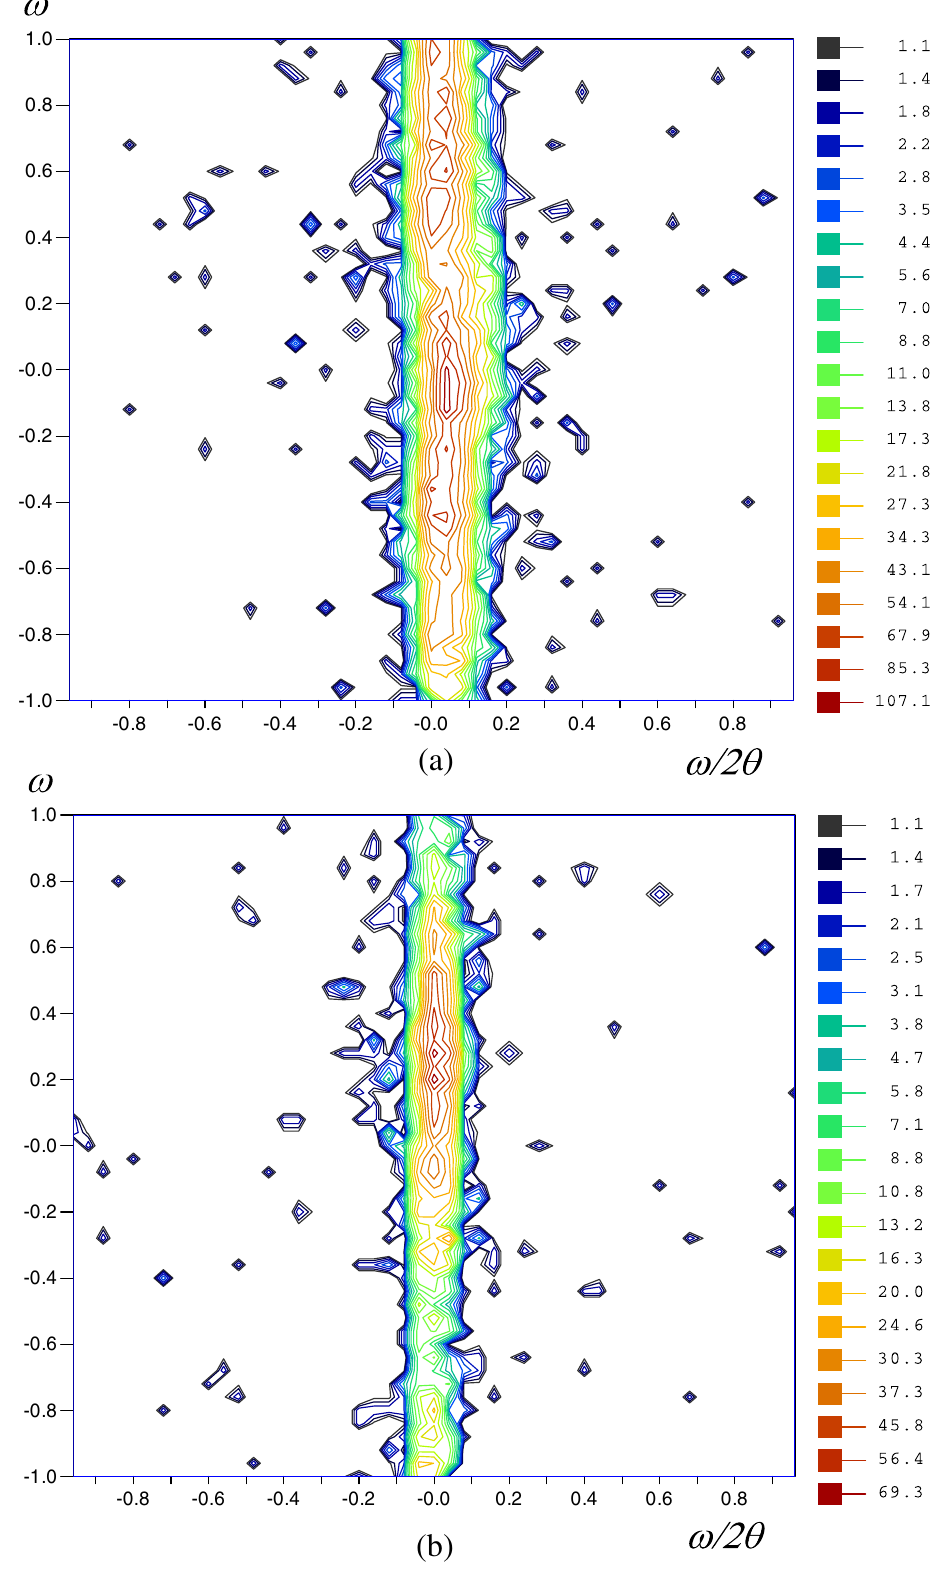
FIG. 6 (color online). Experimental RSM graphs of bulk polycrystalline sample Nb-PC-01 as described in Table IV. (a) Shallow penetration; (b) deep